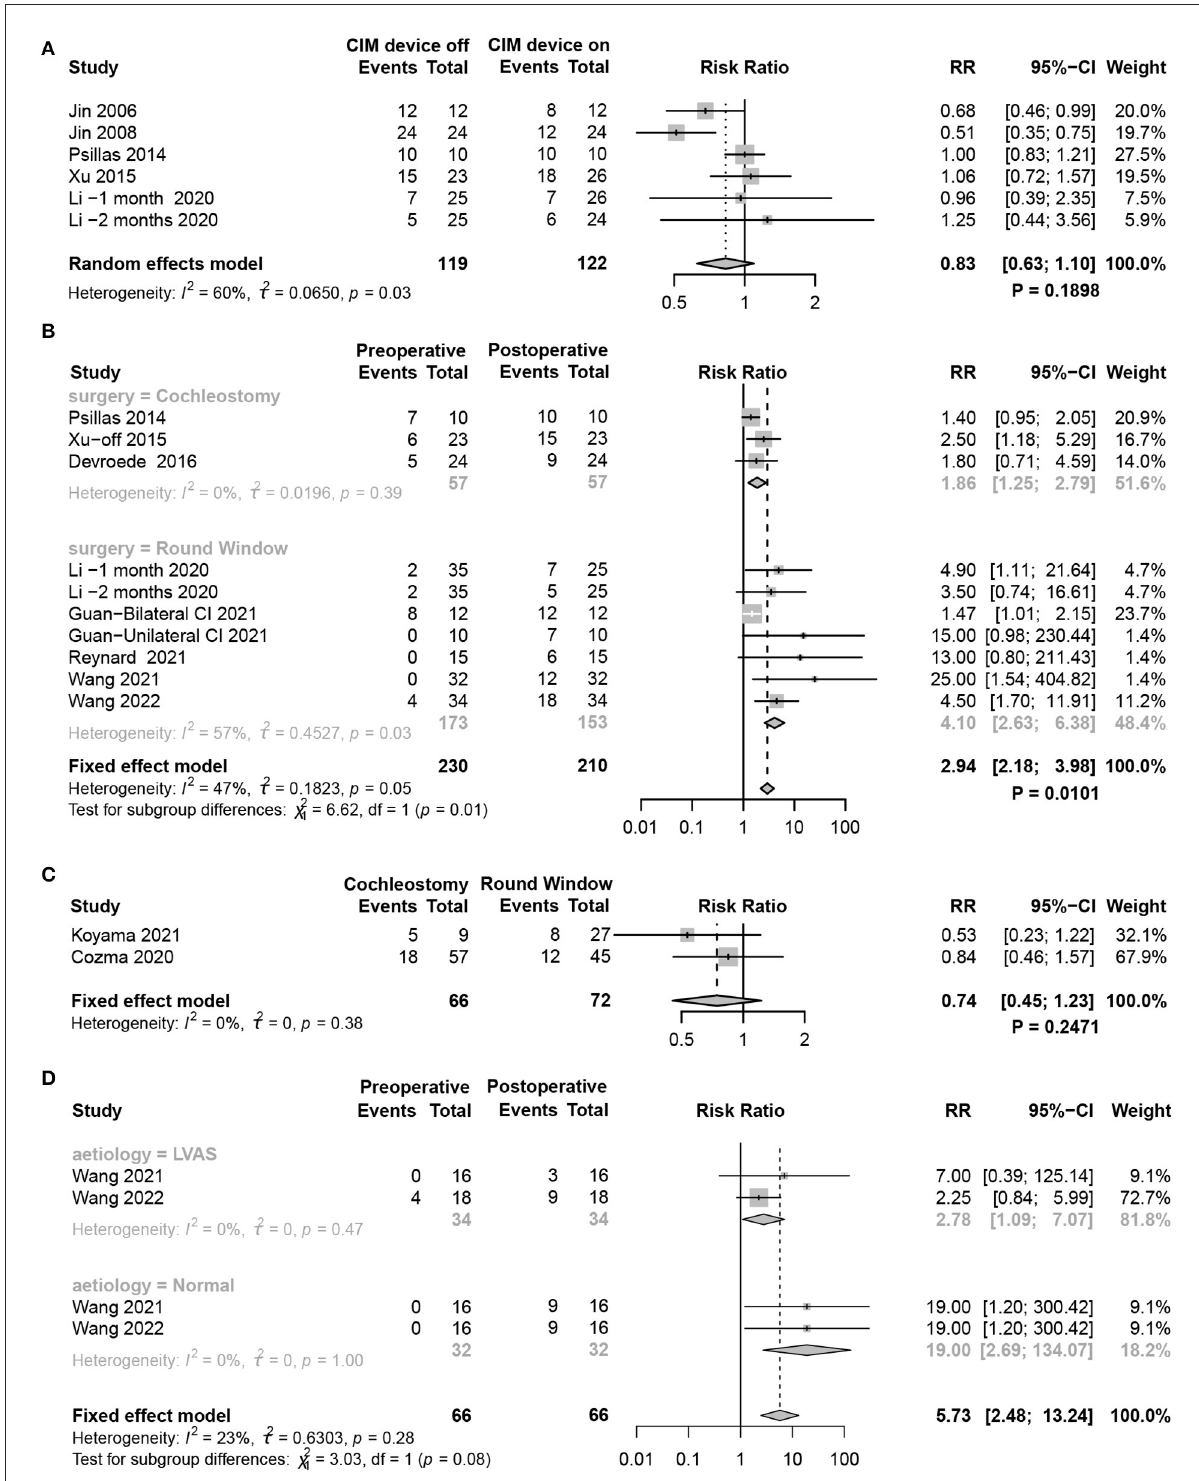
FIGURE6 Forest plots showing factors affecting vestibular function changes. (A) cVEMP test comparing CIM devices on and off. (B) Subgroup analysis of patients using RW and cochleostomy. (C) Comparison of the effect of RW and cochleostomy on vestibular function. (D) Subgroup analysis comparing the effect of LAVS and normal patients on vestibular function. Study, included studies for Research on meta-analysis; CIM device off, postoperative results of vestibular function test with CIM devices off; CIM device on, postoperative results of vestibular function test with CIM devices on; Preoperative, results of vestibular function test before operation; Postoperative, results of vestibular function test after operation; Cochleostomy, cochleotomy implantation group; Round Window, round window implantation group; Events, number of people with abnormal vestibular function test results; Total, total number of patients in the study; RR, relative risk; 95%-CI, 95 confidence interval; Weight, weight of each study in